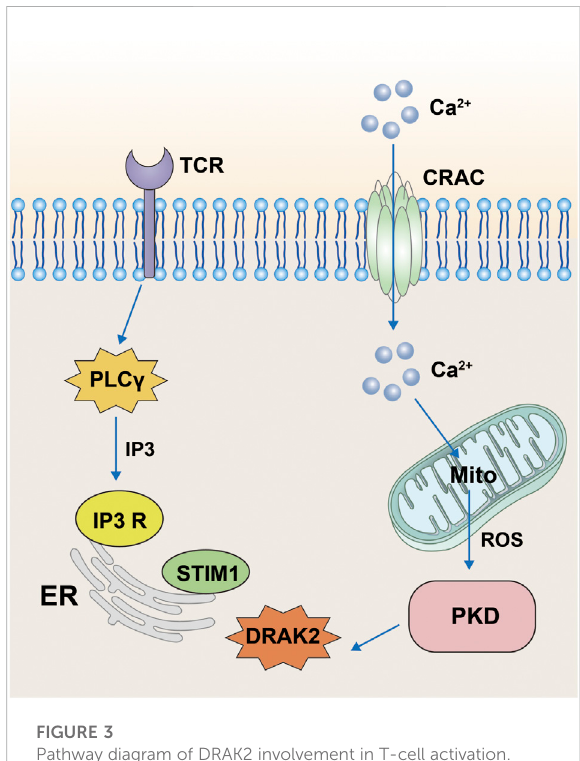
FIGURE 3 Pathway diagram of DRAK2 involvement in T-cell